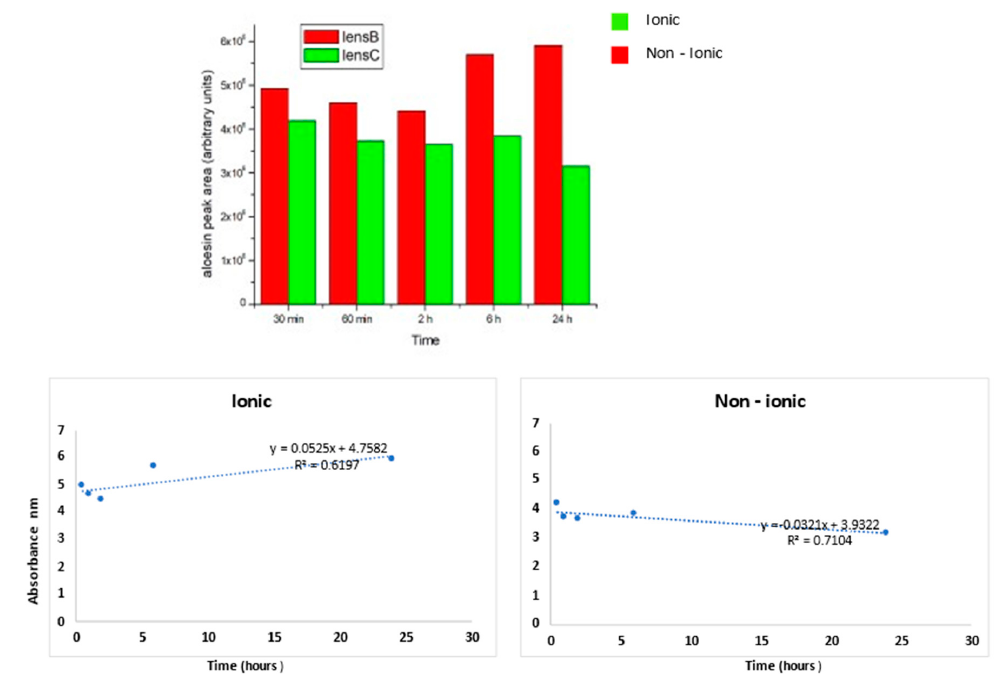
Figure 5. The aloesin release was higher for the ionic lens than non-ionic lens at all times tested. For the ionic lens, the regression line equation displays a positive angular coefficient with a high R 2 value, thus indicating a continuous aloesin release from the lens increasing from 2 to 24 h. For the non-ionic lens, the regression line equation displays a negative angular coefficient with a high R 2 value, thus indicating a decrease of aloesin release from the lens from 2 to 24 h.